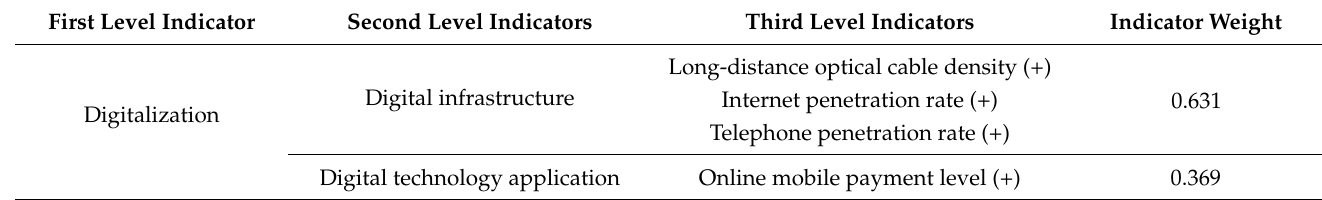
Table 1. Index selection and weight for digitalization.